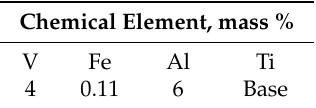
Table 1. Chemical composition of the alloy Ti-6Al-4V.